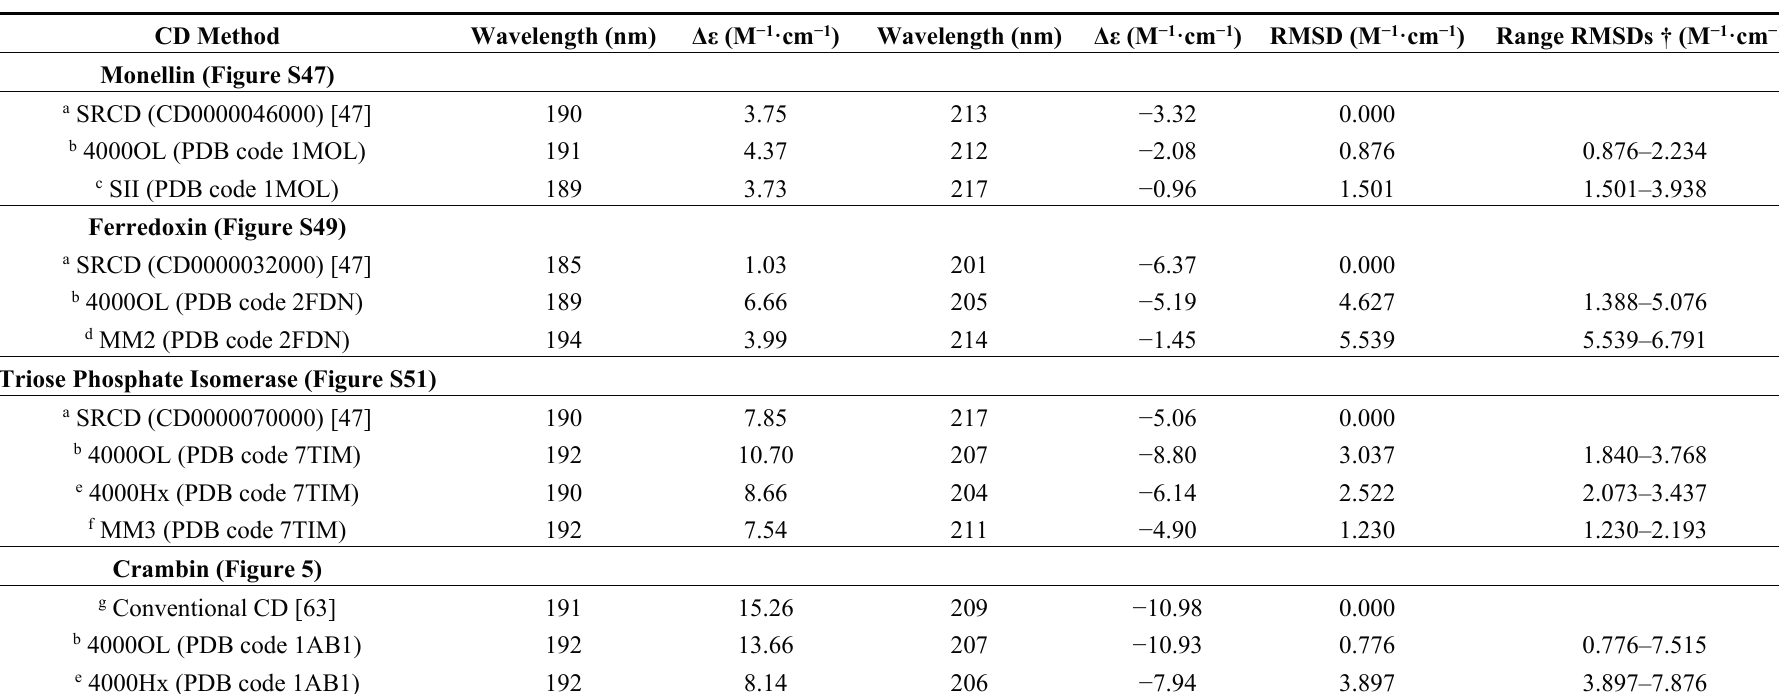
Table 3. CD Analysis of α / β proteins. The DInaMo calculations are for the minimized or rebuilt structure using CDCALC or CAPPS. All RMSDs are calculated between 180 and 210